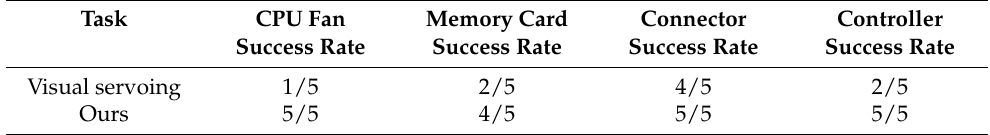
Figure 17. The experiment result. The left side shows the human demonstration phase that 3D imitated trajectories and 2D line features used for visual servoing are generated from human demon- stration. The right side shows the robot execution phase which the robot approaches the goal position and switches to visual servoing for precision positioning. Table 1. Result of successful trials for each